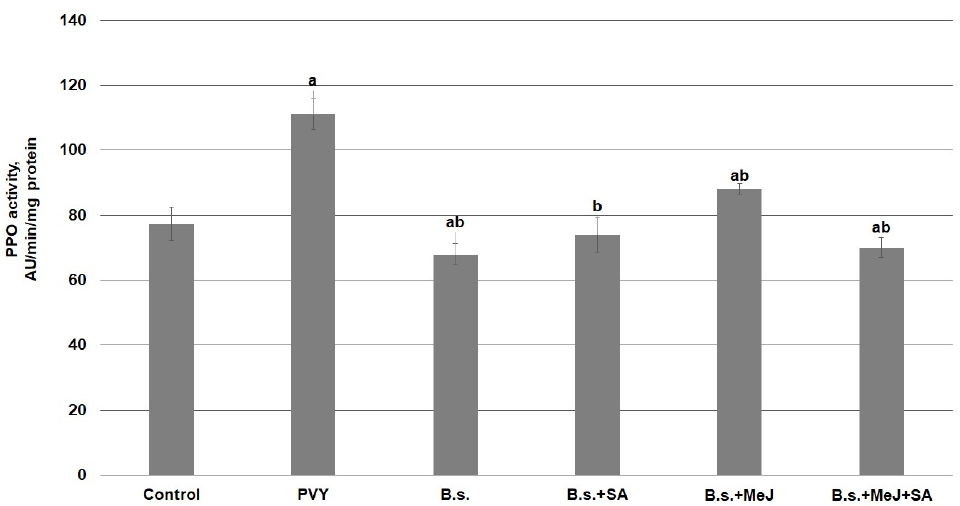
Figure 5. Effect of PVY infection and the mixture of B. subtilis with SA and MeJ application un- der soil water deficiency on PPO activity. Control—health plants; PVY—infected with PVY plants; B.s.— B. subtilis + PVY; B.s. + SA— B. subtilis + salicylic acid + PVY; B.s. + MeJ— B. subtilis + methyl jasmonate + PVY; B.s. + MeJ + SA— B. subtilis + salicylic acid + methyl jasmonate + PVY. a—indicates means that are statistically significantly different from the control, b—indicate means that are statisti- cally significantly different from the PVY.